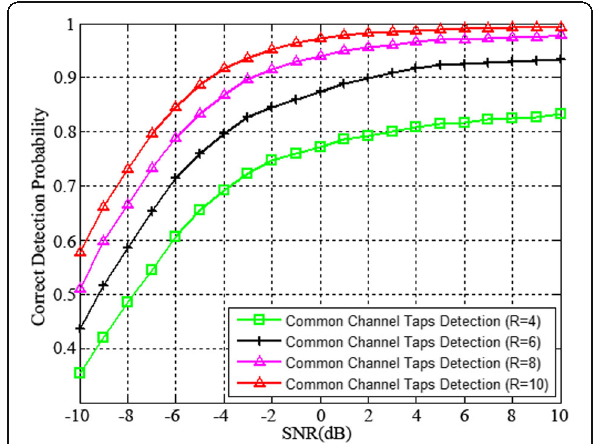
Fig. 2 Correct detection probability of common channel taps with